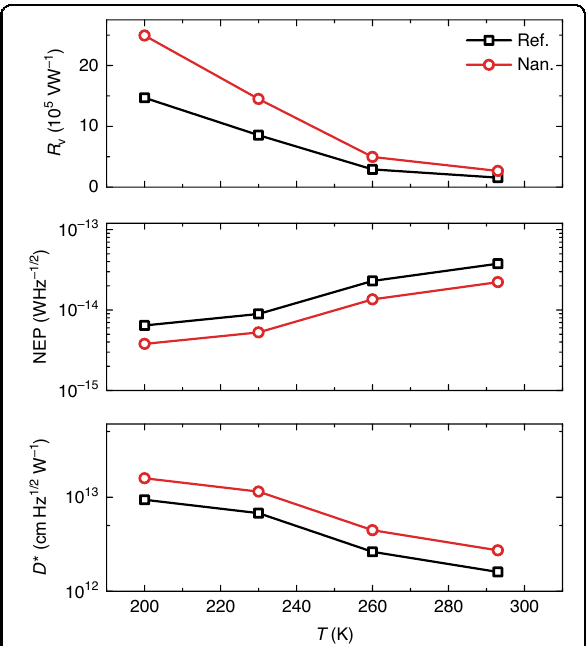
Fig. 5 Performance vs. temperature. R v , NEP, and D * of the devices at different temperature under a voltage bias of 1000 mV at 0.171 THz.